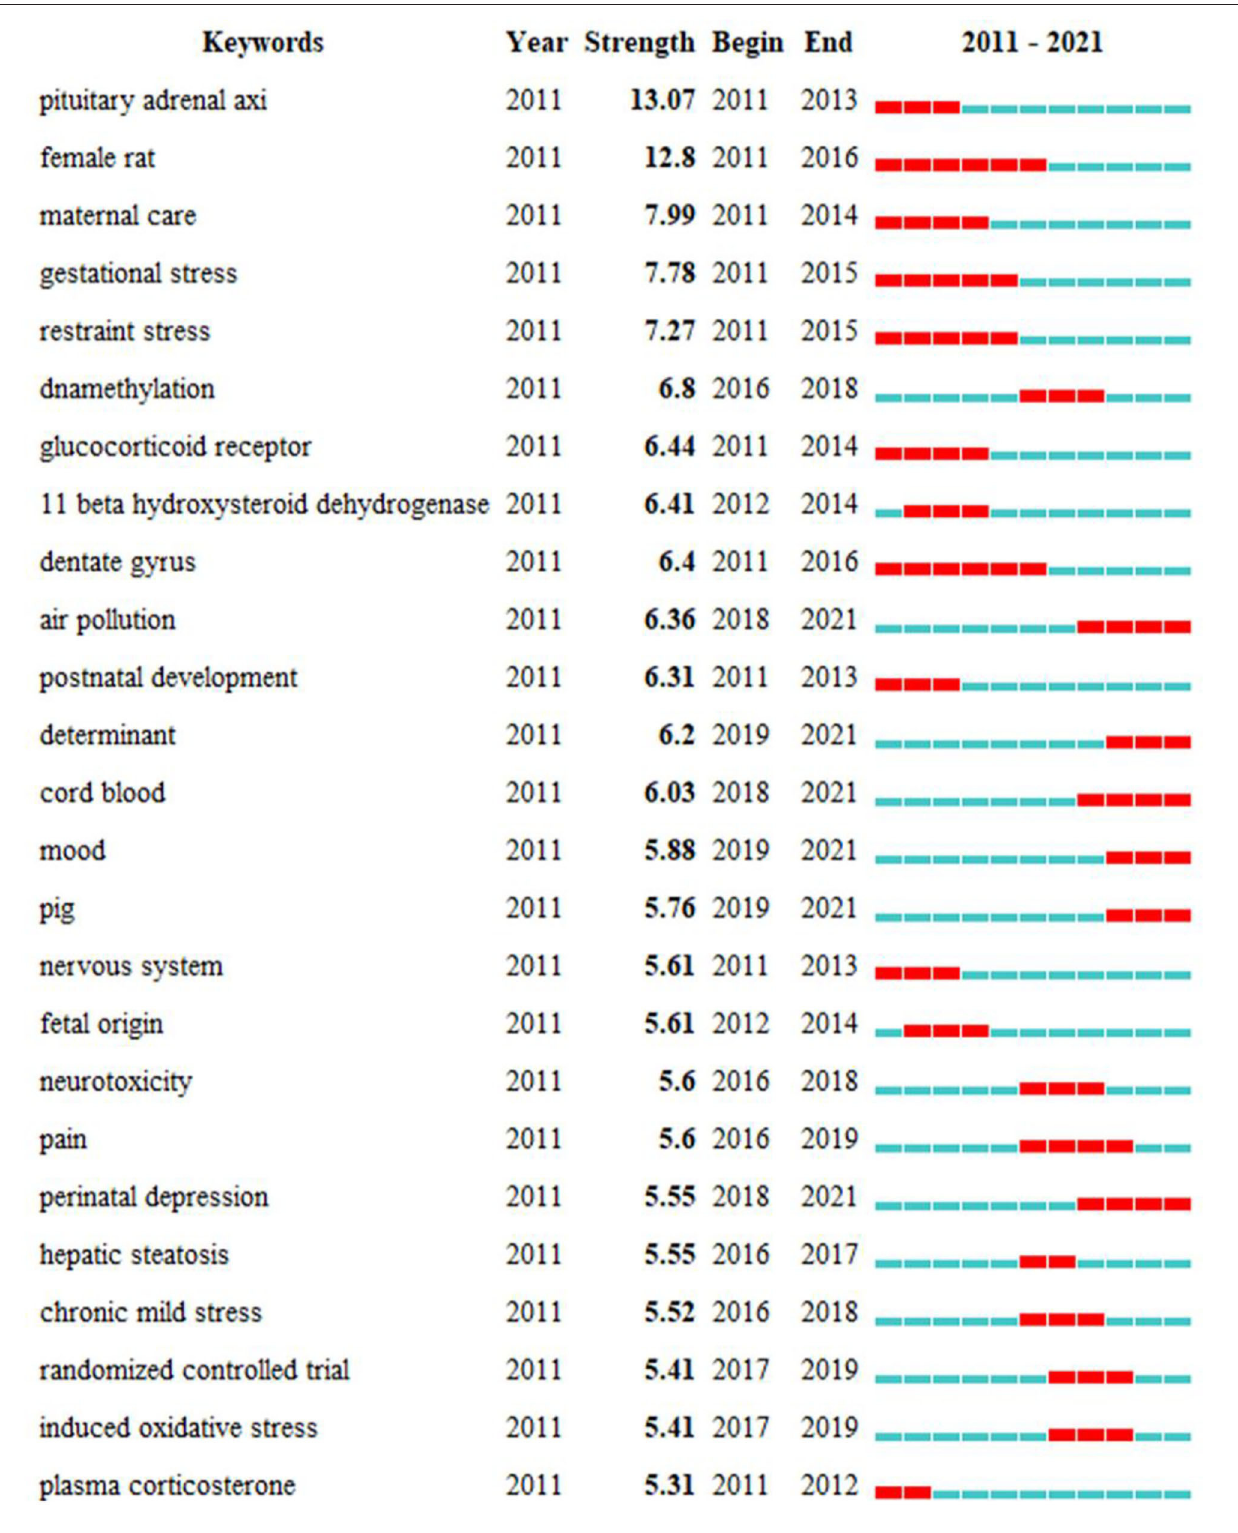
Frontiers in Pediatrics |